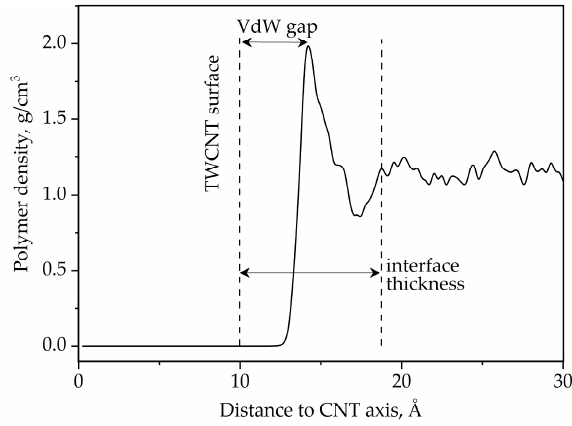
Figure 4. Description of polymer density profile (obtained from Model 1b). VdW = Van der Waals gap.